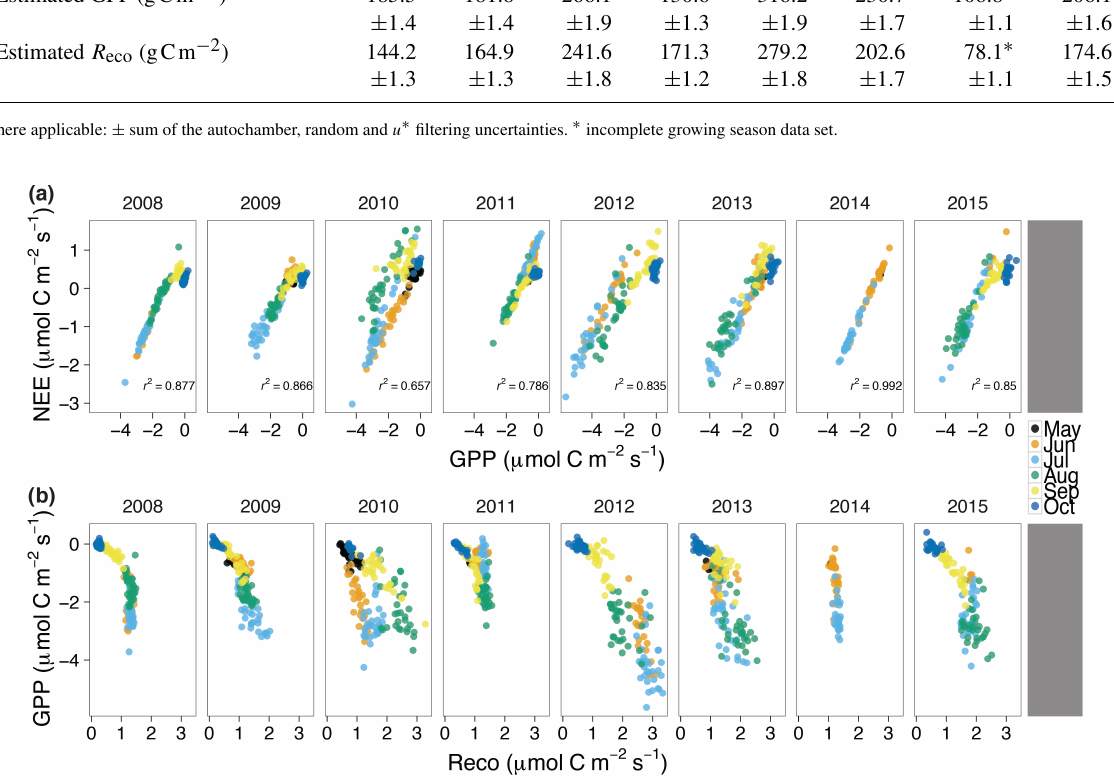
Figure 6. Interannual variability between (a) NEE–GPP and (b) GPP- R eco relationships. The data were daily aggregated and coloured per